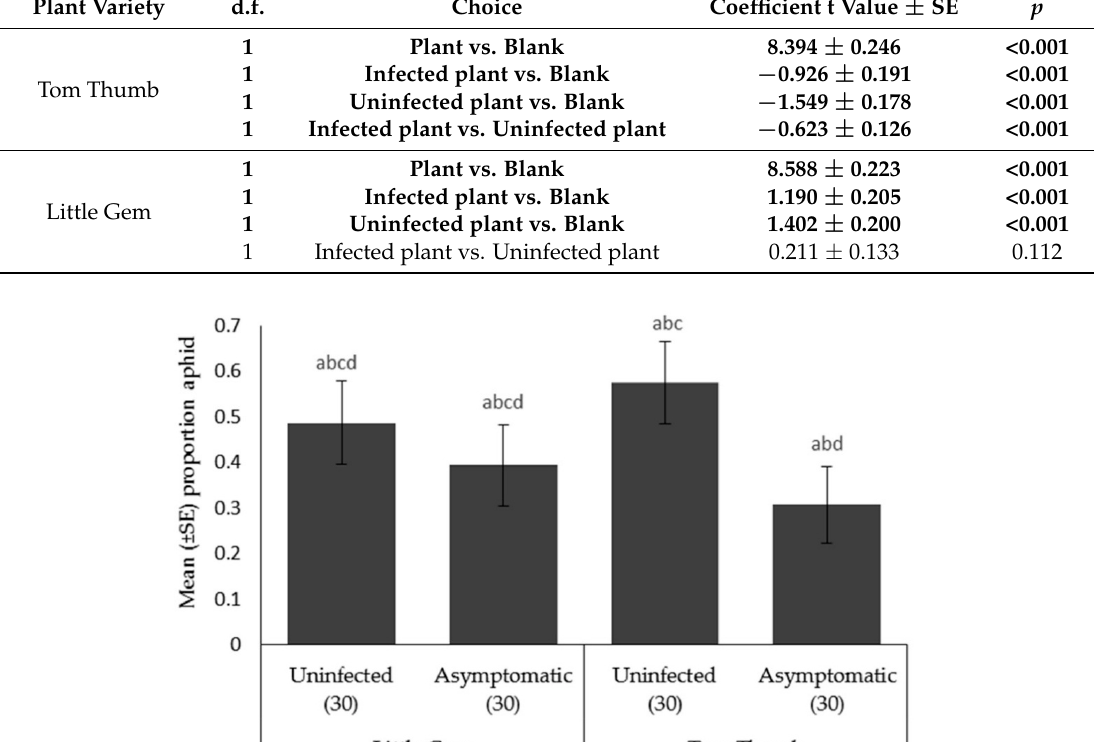
Table 5. Summary of effects of plant infection status on aphid host plant preference behavior on two lettuce varieties. N = 30 for each treatment. Significant values are in bold.